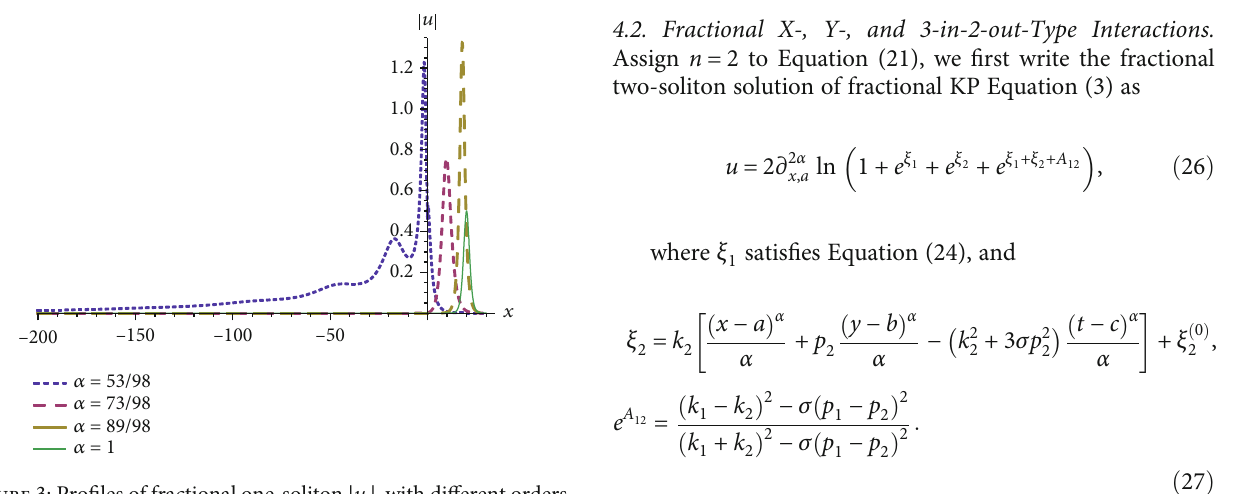
= 1 , p = 1/2 , σ = 1 , ξ ð 0 Þ = 0 , and t = 0 . 1 1 1